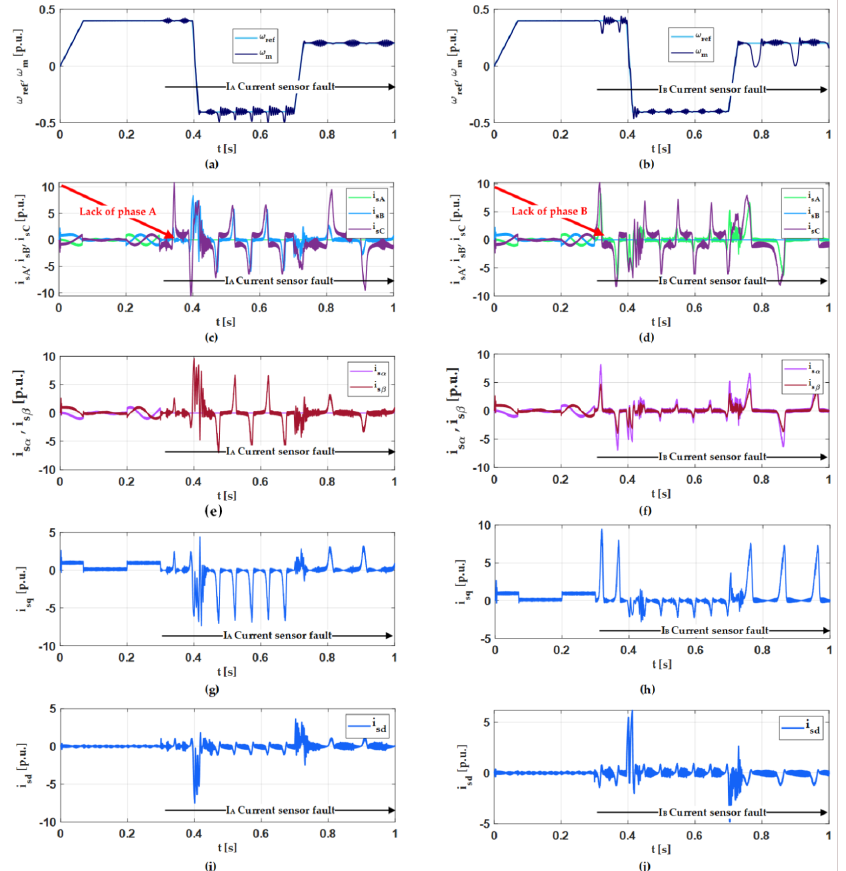
Figure 6. Influence of lack of signal on speed transient in phase A ( a ) and B ( b ), phase currents, currents i sA , i sB , i sC in phase A ( c ) and B ( d ), stator current components i s α , i s β in phase A ( e ) and B ( f ) and currents i sd , i sq in phase A ( g , i ) and B ( h , j ) in the FOC